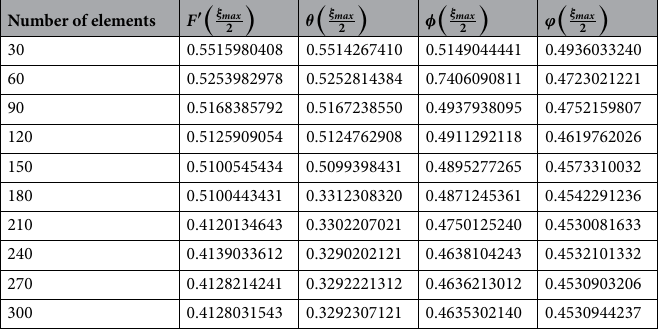
Table 2. Simulations regarding mesh free investigations via 300 elements.